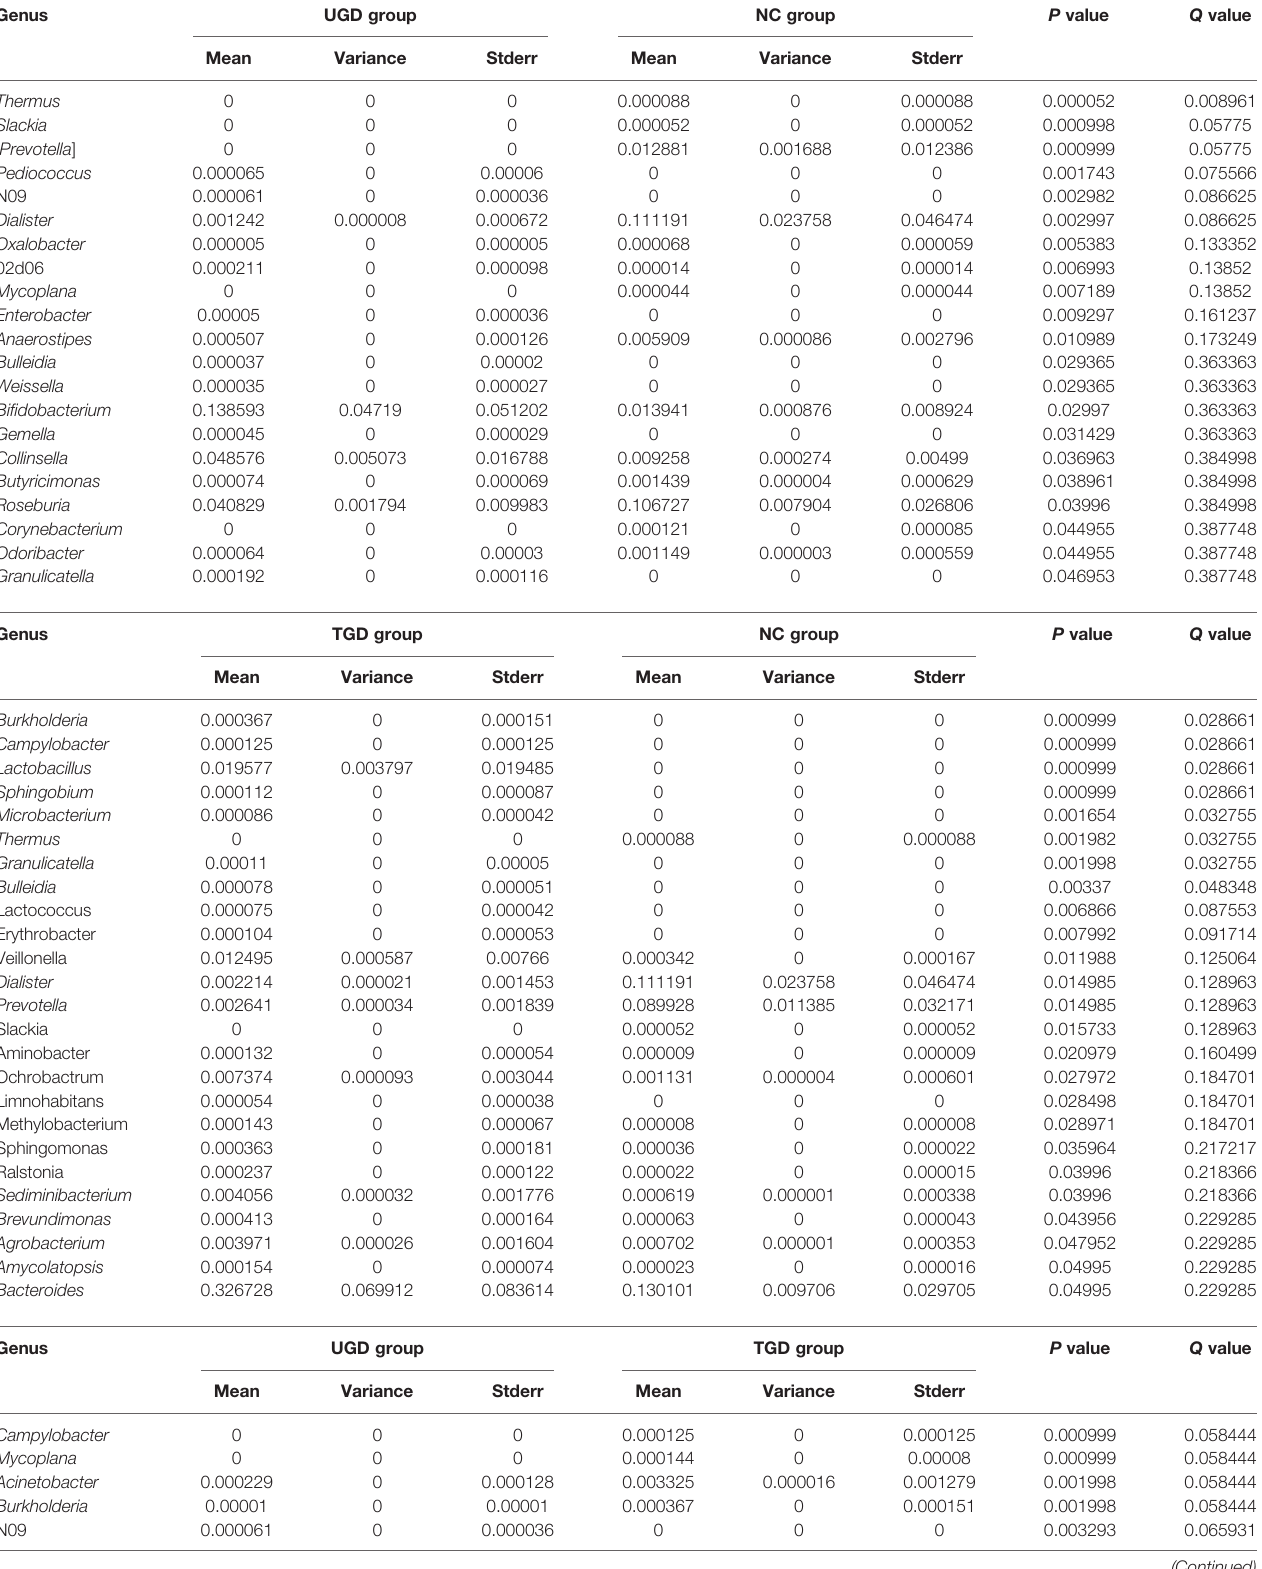
TABLE 5 | Statistical table for the comparison of the Metastats test results among the 3 groups at the genus level. Genus